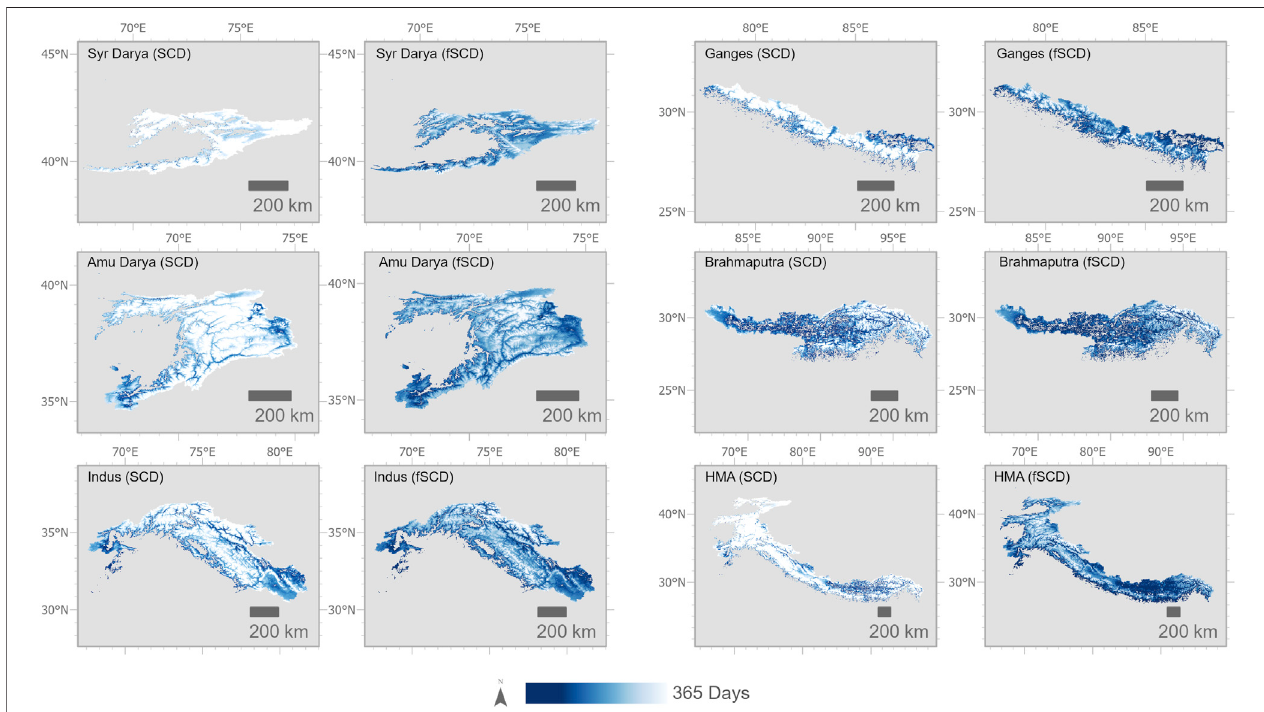
FIGURE3| Anexampleofbinarysnow-covereddaysandfractionalsnow-covereddaysfromMODSCAG-STCfortheyear2002forthestudyarea.Avalueof365, represented by the color white, indicates snow cover at 15% or greater for SCD and a value of 100% snow cover for fSCD.